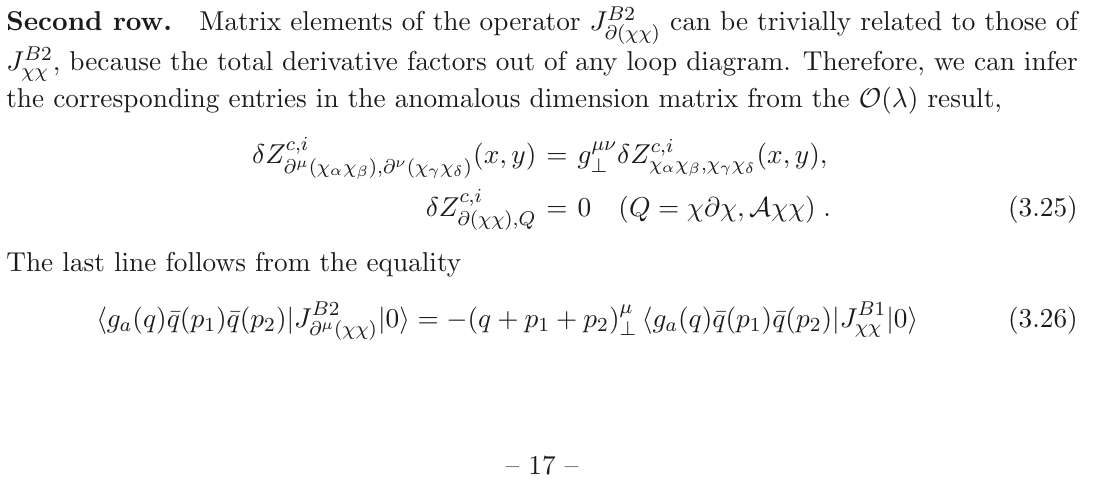
the open adjoint index of the colour-space operators, which generates the additional colour label required for the gluonic building block of A χχ